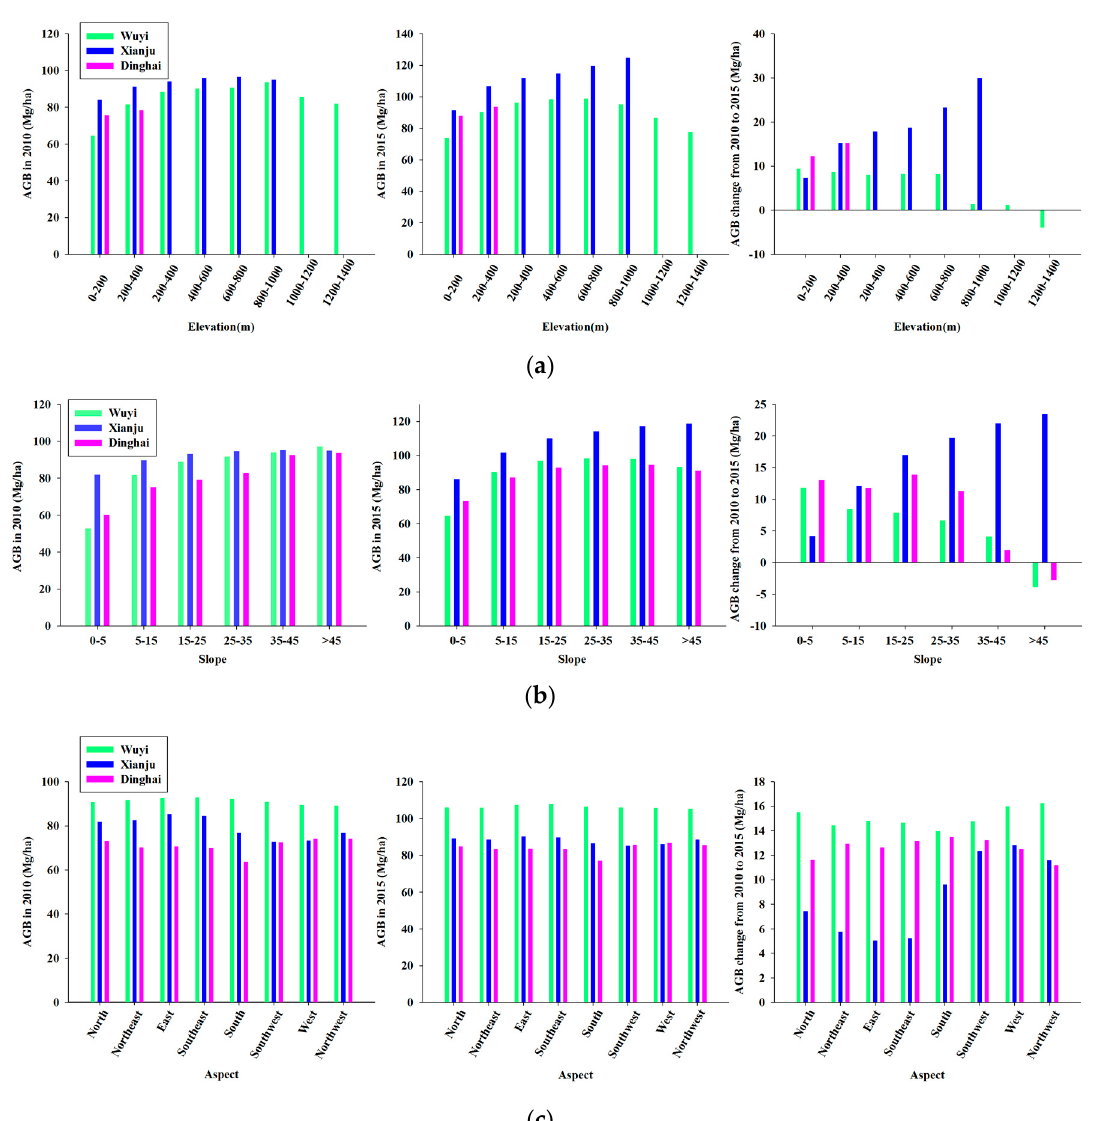
Figure 10. AGB/change within the stratified topography in the three regions: ( a ) AGB/change with stratified elevation; ( b ) AGB/change with stratified slope; ( c ) AGB/change with stratified aspect.